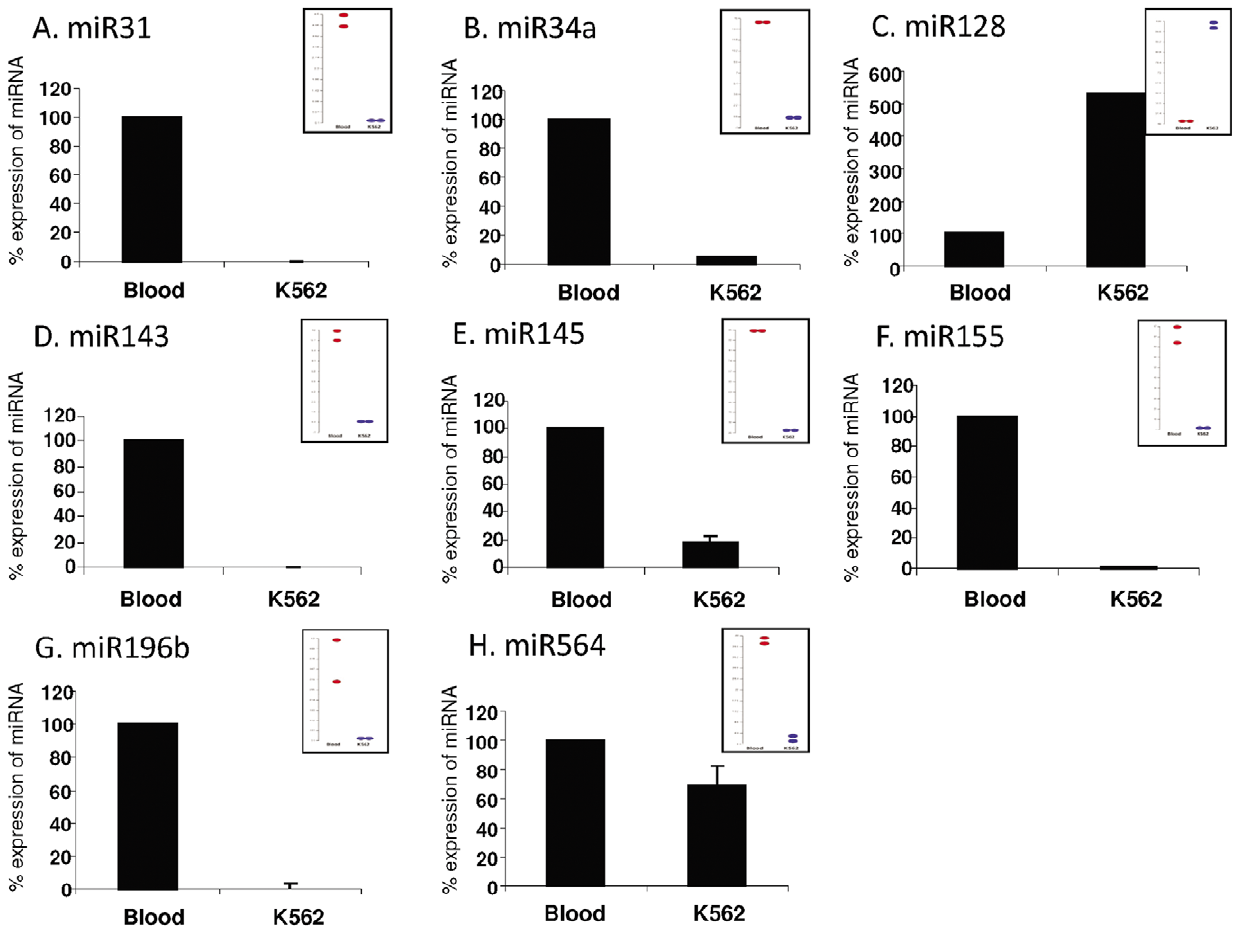
Figure 2. Real-time RT-PCR validation of microarray results, presenting changes in miRNA expression in K562 cells as compared to a pooled sample of healthy blood. The expression of A. miR-31, B. miR-34a, D. miR-143, E. miR-145, F. miR-155, G. miR-196b and H. miR-564 was downregulated whereas the expression of C. miR - 128 was upregulated in K562 cells compared to healthy blood. The histograms show percentage of miRNA expression normalized to U6-snRNA 6 SEM from at least 3 experiments. Insets show microarray expression results for the specified miRNAs (Blood: red circles; K562: blue circles).